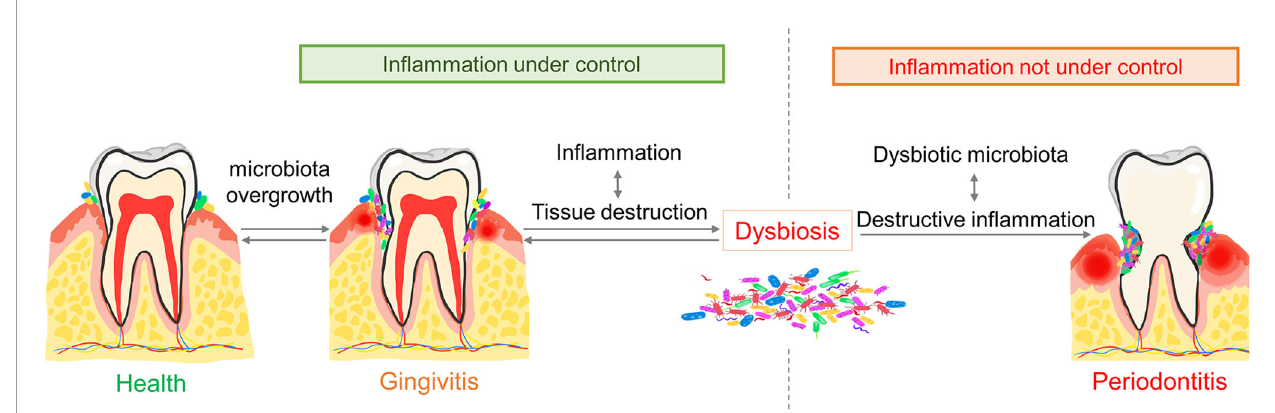
FIGURE 1 | The pathogenesis of periodontitis. The overgrowth of commensal microbiota triggers gingivitis. Gingival in fl ammation then provides nutrients and a local anaerobic environment for periodontal pathogens. The overgrowth and diversity of periodontal pathogens exaggerate in fl ammation which decides the progression of gingivitis. Dysregulated in fl ammation together with microbial dysbiosis lead to periodontitis. Conversely, balanced in fl ammation leads to quiescent